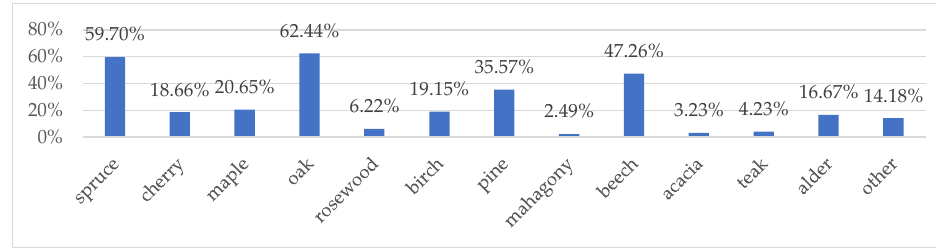
Figure 1. Processed wood plants at the production of woodworking and furniture enterprises (WFPs).